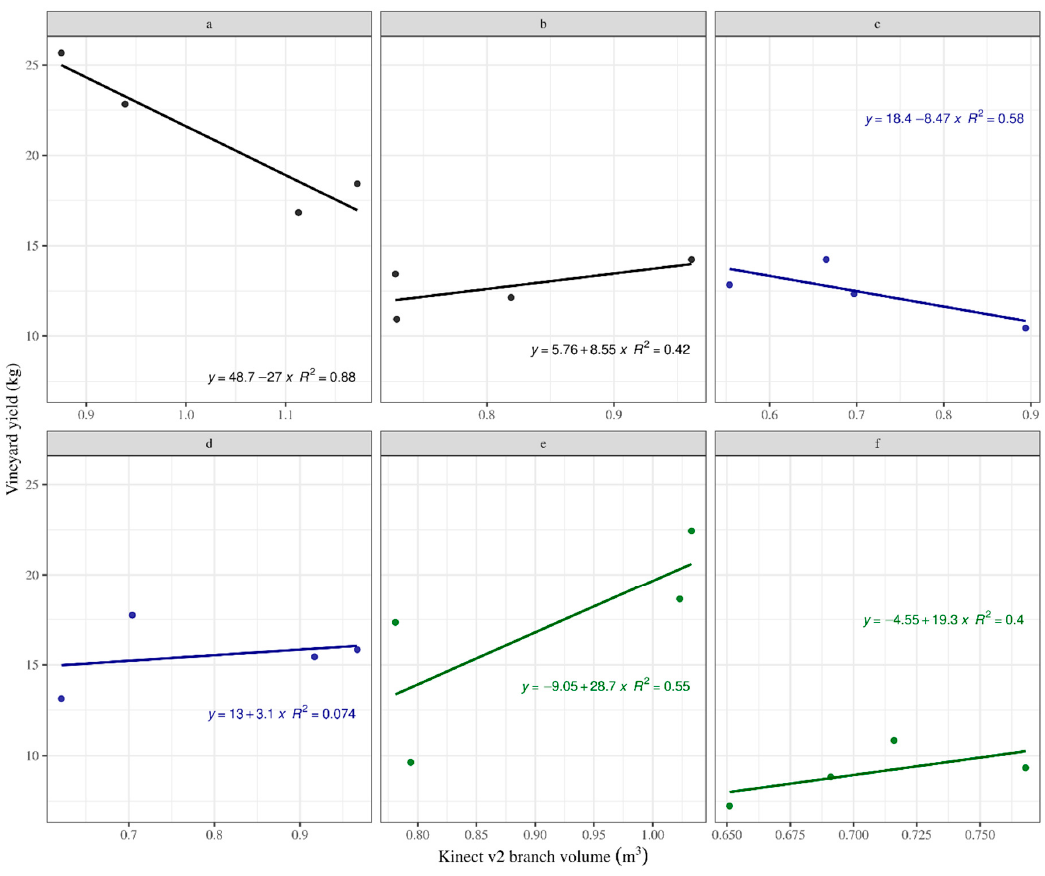
Figure 8. Kinect branch volume versus vineyard yield including the effect of treatment.